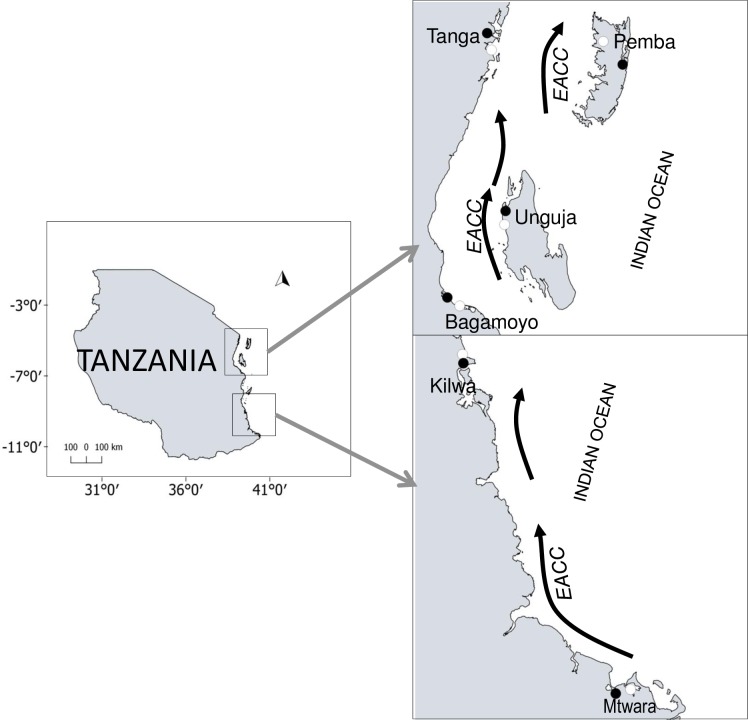
Map showing sample sites of the fiddler crab Austruca occidentalis from the Western Indian Ocean (partial mitochondria cytochrome oxidase subunit I (COI) sequences and microsatellites).The white filled circles represent natural mangroves and black filled circles represent mangroves at salt ponds. The East African Coast Current (EACC) is indicated by black arrows.